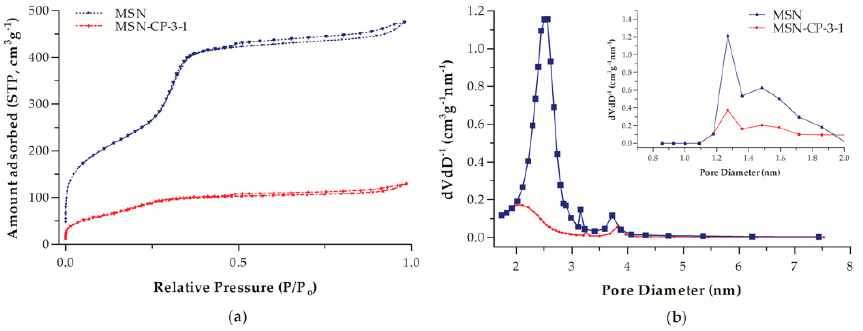
Figure 2. ( a ) Nitrogen adsorption and desorption isotherms and ( b ) pore size distribution of bare MSN (MCM-41) and MSN-CP-3-1. Table 1. Surface area and pore volume values of MSN (MCM-41) and